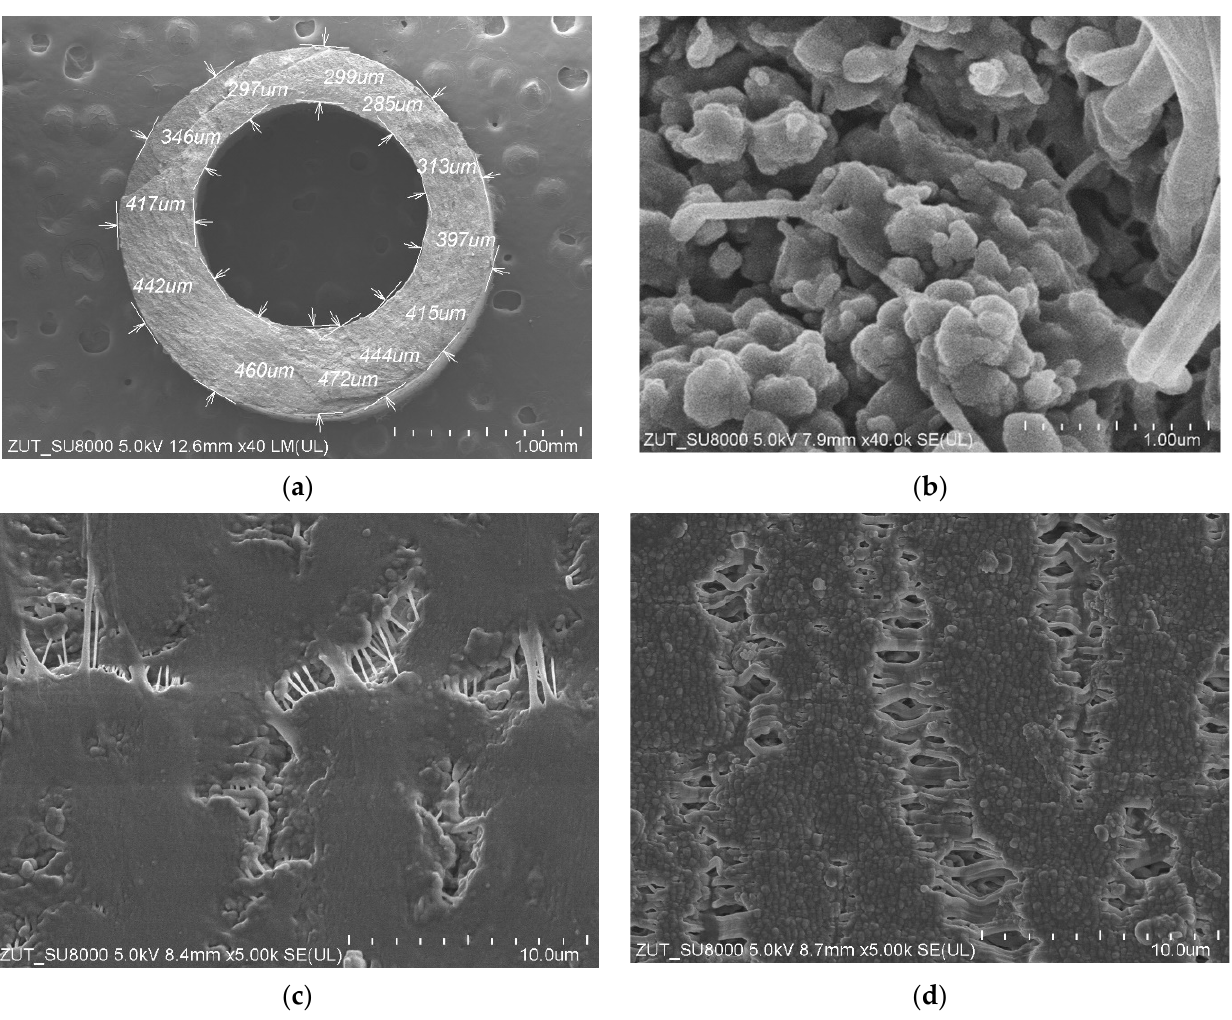
Figure 4. SEM images of the capillary PTFE membrane collected from the M#1 module after 2000 h of the MD process run (T F = 60 °C): ( a ) capillary cross section; ( b ) wall cross section; ( c ) external surface; ( d ) internal surface.